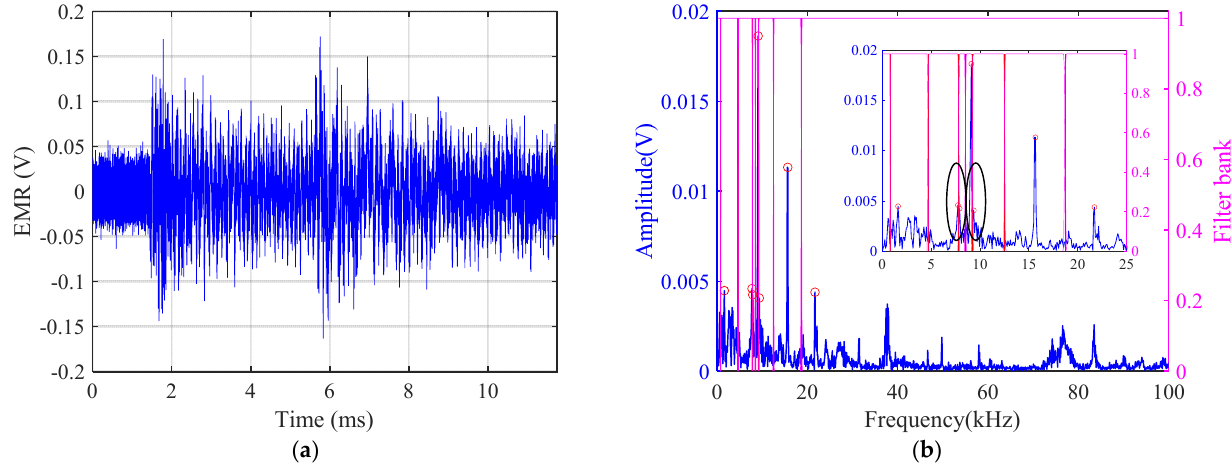
Figure 1. Example of conventional Fourier axis segmentation for EMR waveform: ( a ) EMR waveform; ( b ) result of Fourier axis segmentation.